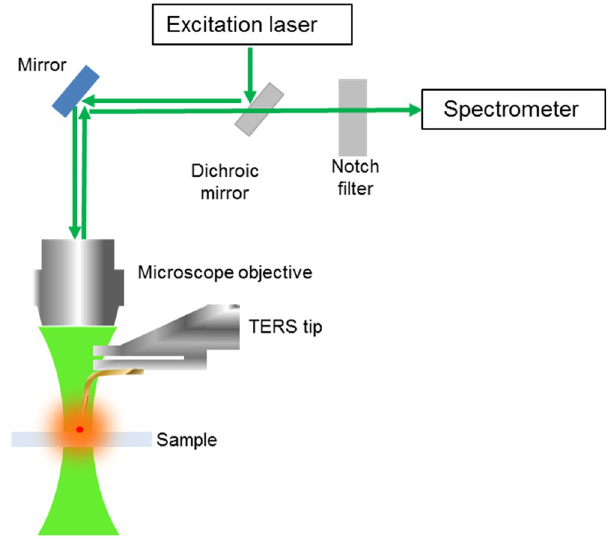
Figure 1. Schematic of the optical set-up for generating TERS.